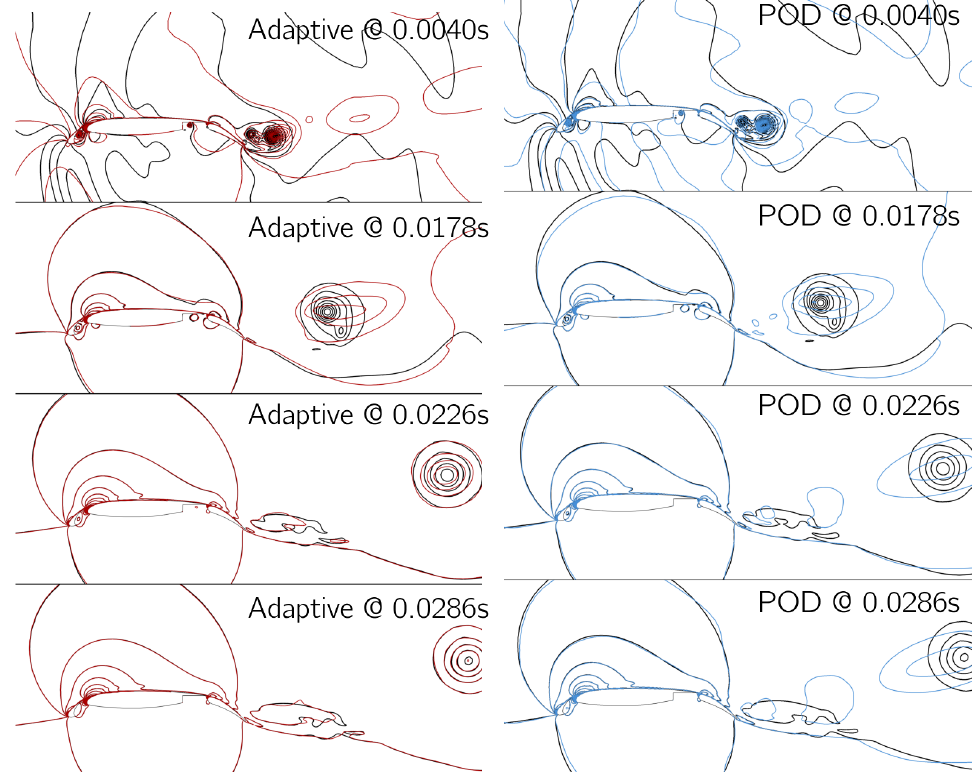
Figure 10. Comparison of the volume solution in terms of ρ . Coloured lines show the ROM recon- struction, while the black lines show the reference CFD solution. The left column shows the adaptive reconstruction; the right columns shows the pure POD reconstruction.